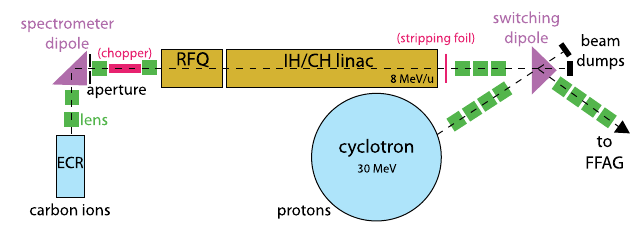
FIG. 29. The beam injection scheme.